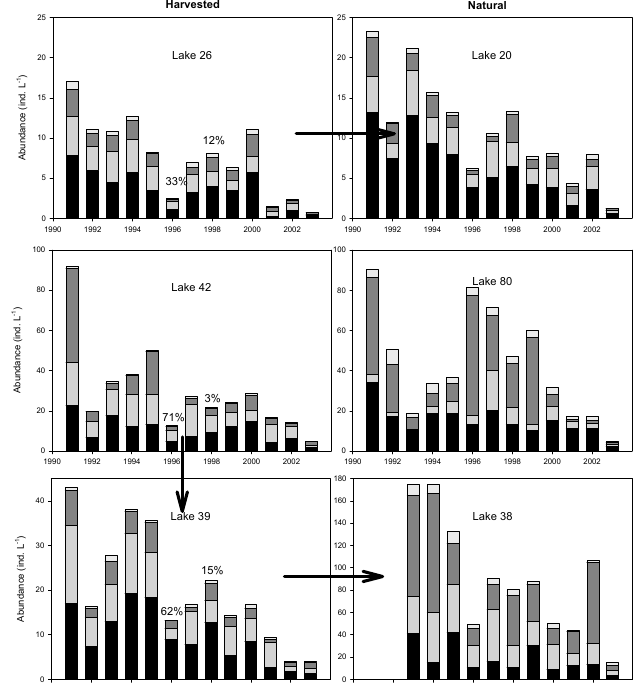
Figure 3. Stacked barplot of the abundance of total zooplankton (Ind.·L − 1 ) and the relative abundances of taxonomic groups in the six monitored lakes from 1991 to 2003 (black: Cyclopoida; pale grey: Calanoida; dark grey: Rotifera; white: Cladocera). Arrows represent connectivity between lakes. Percentages of the watershed deforested by clearcut logging in 1996 and 1998 are also shown for harvested lakes.